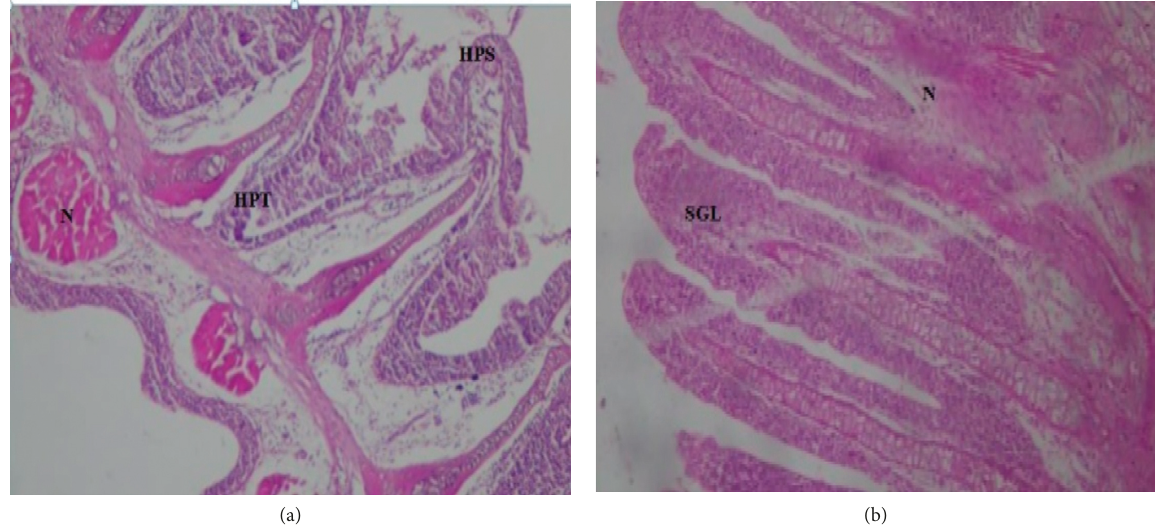
Figure 11: (a) Histological section of gill exposed to bulk SiO/CuO (1: 2) showing epithelial hyperplasia (HPS), necrosis (N), and hy- pertrophy (HPT) (H&E stains, × 400). (b) Histological section of gill exposed to bulk SiO/Al 2 O 3 (1: 2) showing mild necrosis (N) and